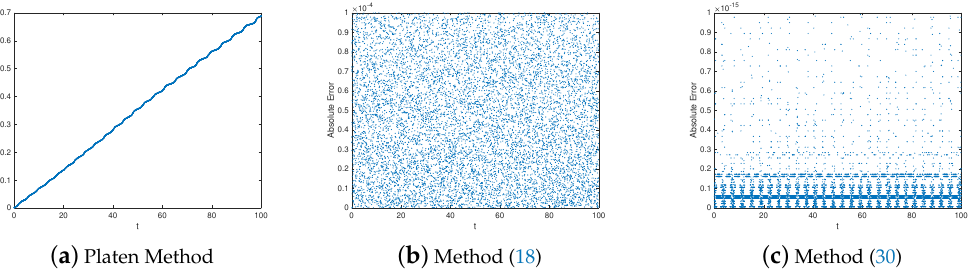
Figure 6. Conserved quantity errors of the Platen method, method (18), and method